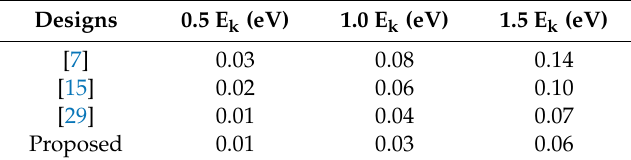
Table 6. Switching energy analysis at T = 2 K.